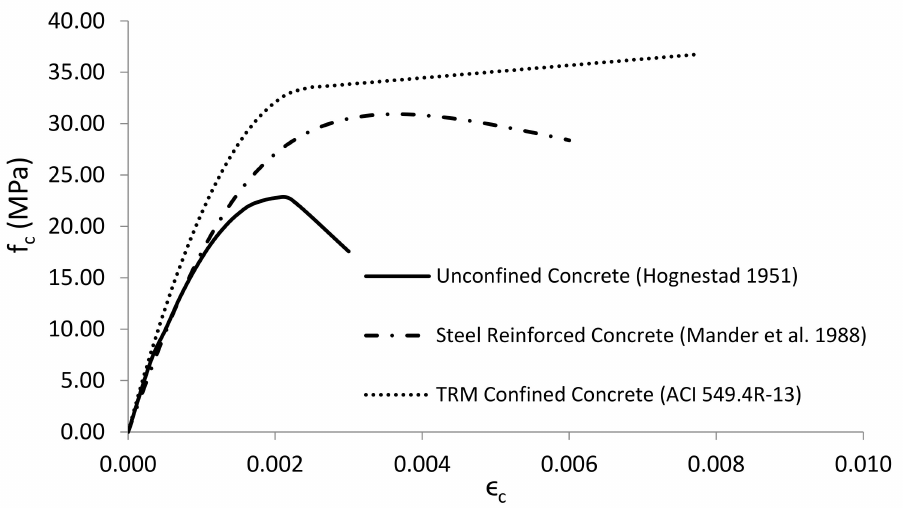
Figure 2. Stress–strain relationships of confined and unconfined